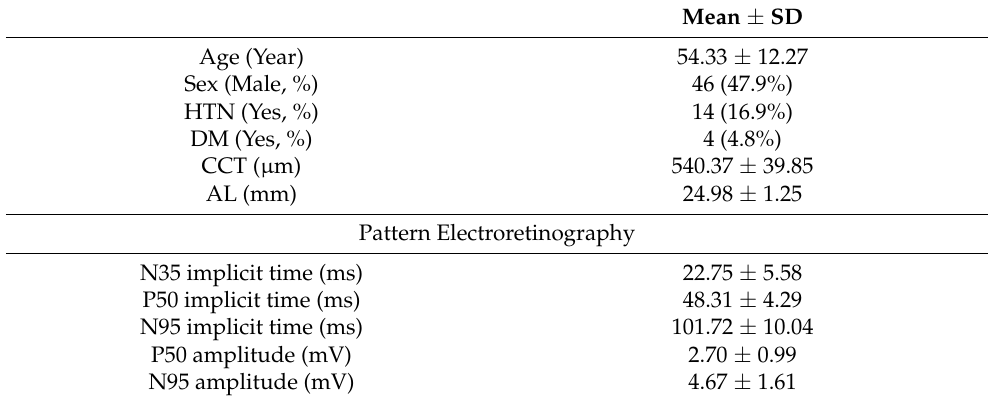
Table 1. Patient’s Demographics (N,